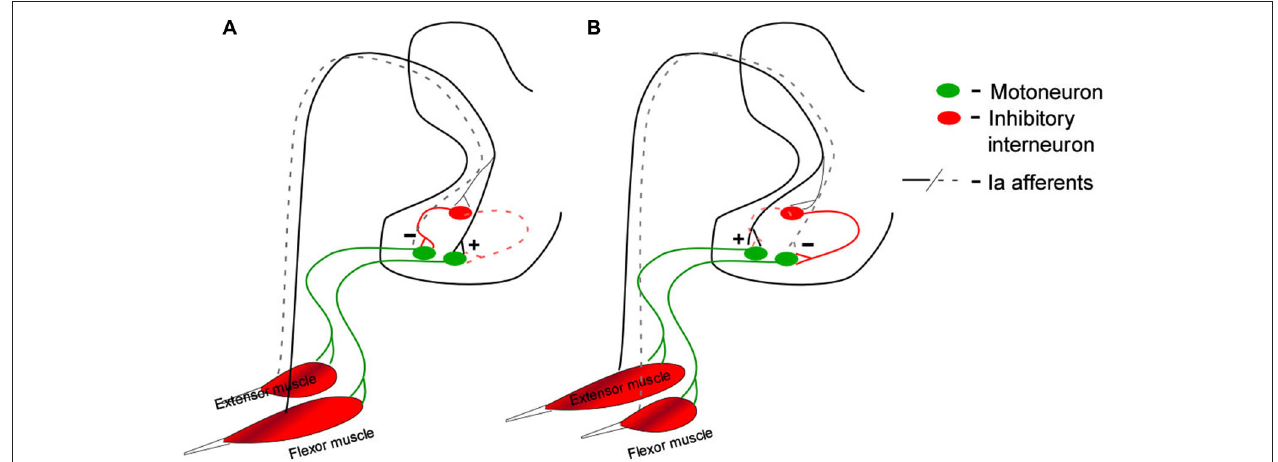
hyperpolarization ( − ). During these rotations the opposite conductance change occurs at each motoneuron type: extensor muscle shortening disfacilitates extensor motoneurons ( A , black dashed lines) contributing to their hyperpolarization, and disinhibits flexor motoneurons ( A , red dashed lines), contributing to their depolarization. Flexor muscle shortening disfacilitates flexor motoneurons ( B , black dashed lines, hyperplolarization) and disinhibits extensor motoneurons ( B , red dashed lines, depolarization).